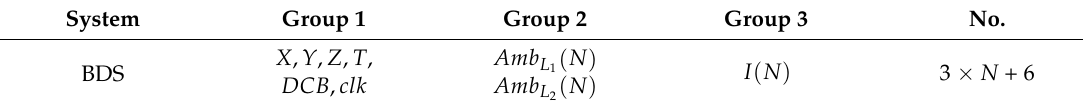
Table 1. The classify of the estimated parameters for PPP based on raw